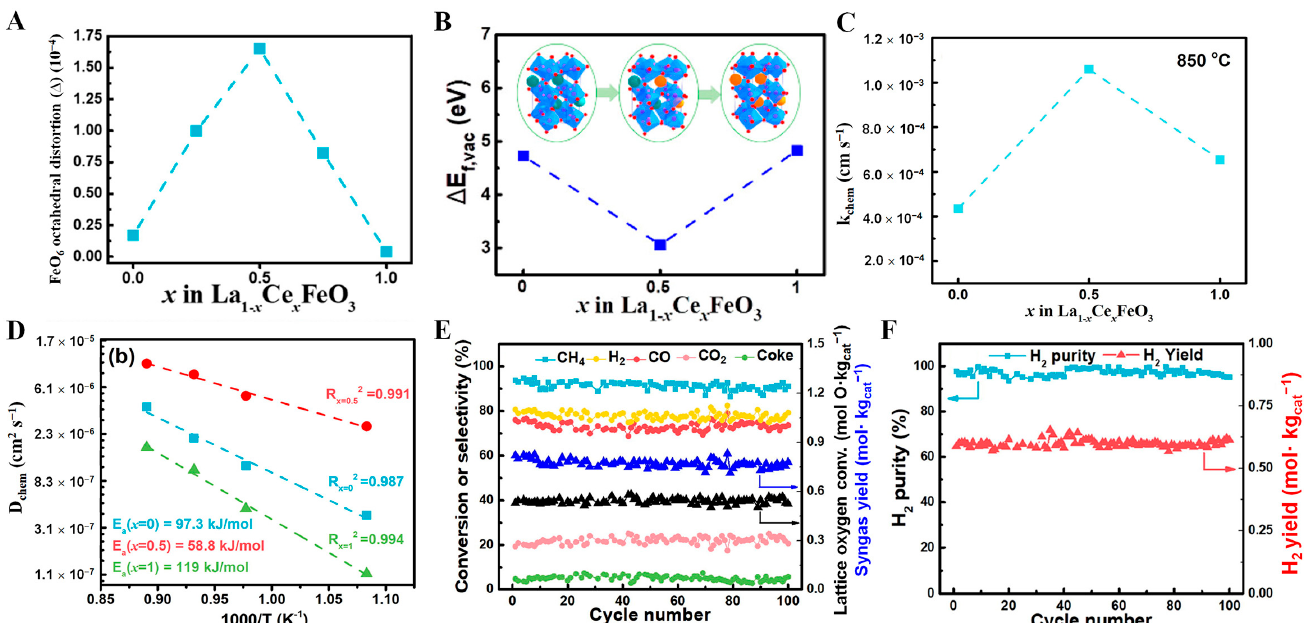
Figure 10. ( A ) Distortion degree ( Δ ) of FeO 6 octahedra for La 1 − x Ce x FeO 3 (x = 0, 0.25 0.5, 0.75, 1) and ( B ) calculated oxygen vacancy formation energy ( Δ E f,vac ) of La 1-x Ce x FeO 3 (x = 0, 0.5, 1). Adapted with permission from Ref. [119], copyright 2020, American Chemical Society. ( C ) The oxygen surface exchange coefficient (k chem ) and ( D ) bulk diffusion coefficient (D chem ) of La 1 − x Ce x FeO 3 (x = 0, 0.5, 1). Redox performance of ( E ) CH 4 partial oxidation step and ( F ) the H 2 O-splitting step over La 5 Ce 5 FeO 3 in CL–SRM at 925 ◦ C. Adapted with permission from Ref. [118], copyright 2020, Elsevier.